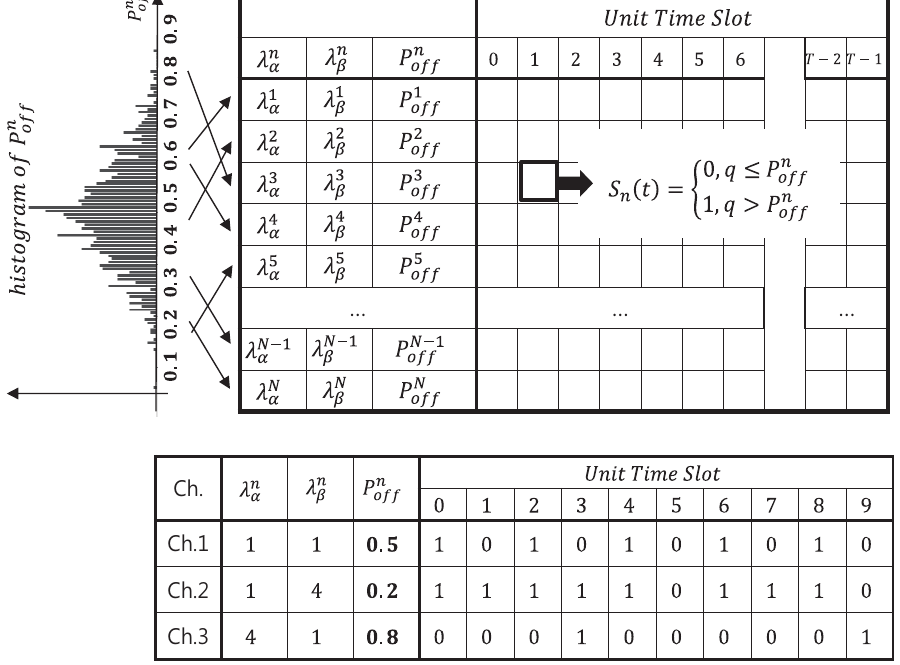
Figure 6. State transitions for occupied and unoccupied states of each channel modeled as zero and one,